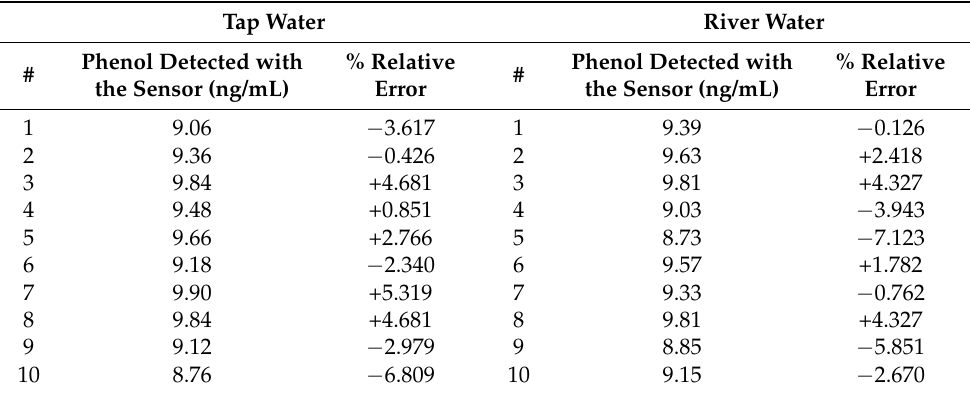
Table 5. Validation results from the recovery of phenol in tap- and river-water samples containing 9.4 ng/mL phenol.